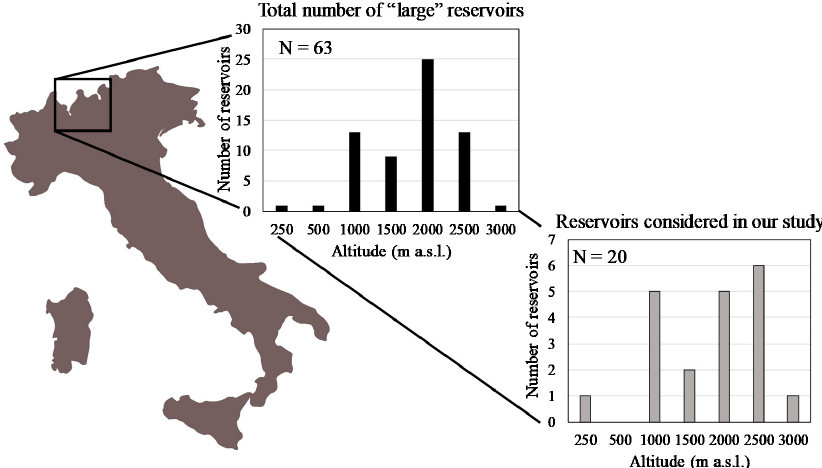
Figure 1. Map of study area in the Central Alps with details about altitudinal distribution of all “large” reservoirs, 20 of which are considered in this study. reservoirs, 20 of which are considered in this